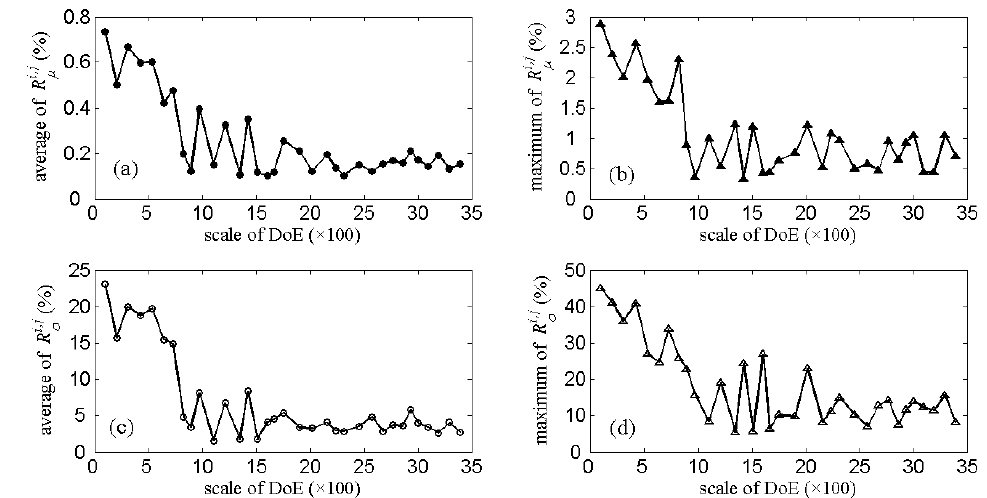
Figure 8. Averages and maximums of change ratios. ( a ) the average change ratio of the mean; ( b ) the max change ratio of the mean; ( c ) the average change ratio of the standard deviation; ( d ) the max change ratio of the standard deviation.